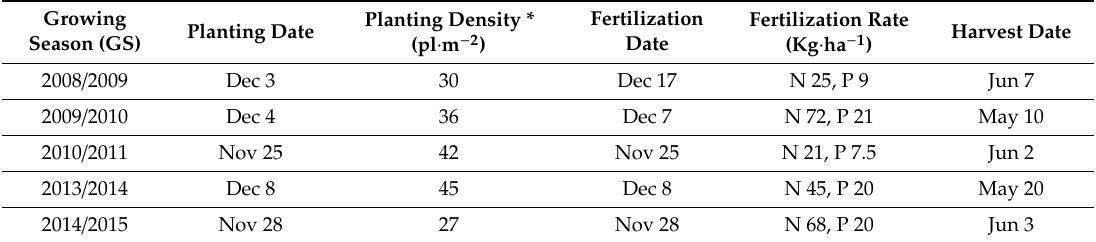
Table 4. Grain sorghum management practices in each evaluated year.